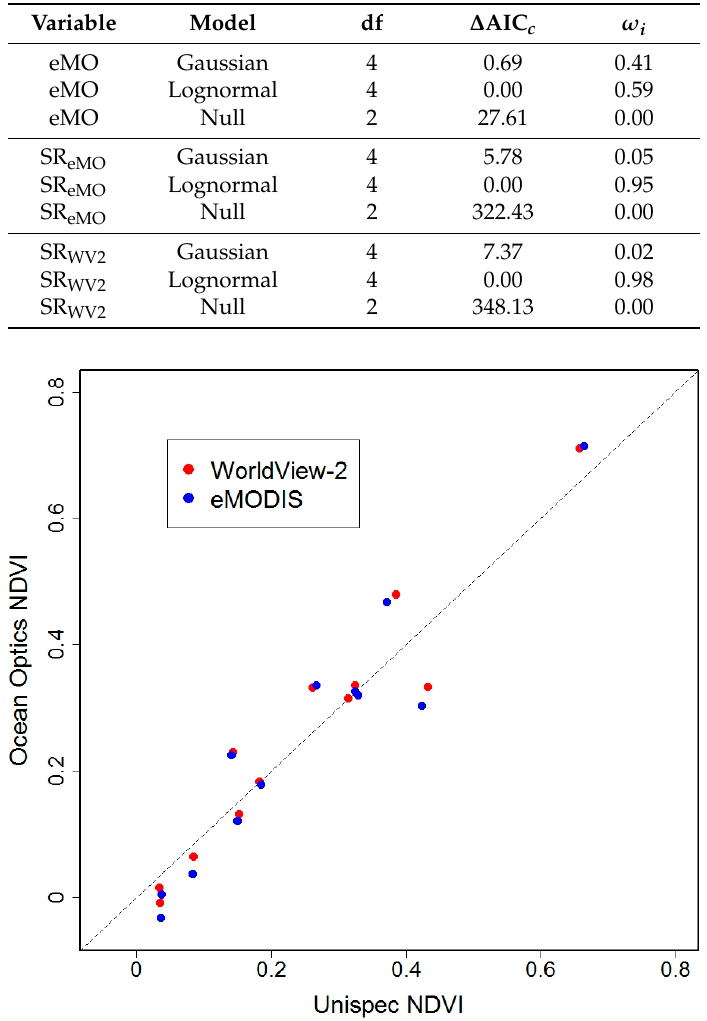
Table A1 . Multi-model selection results for nonlinear curves used to predict seasonal patterns in NDVI and percent nitrogen in halophytic graminoids at the Colville River Delta, Alaska, 2011 ‒ 2015. Results are derived from models fitted with all available data (pooled years) to show overall support for each curve function. eMODIS (eMO) model selection was based on a single pixel value for each date x year combination (n = 46). Spectrometer NDVI curves with eMODIS band definitions (SReMO) and WorldView 2 band definitions (SRWV2) were fit using measurements for all plots at all sampling dates in all years (n = 640). Lowest AIC c scores: − 108.71 (eMO), − 1027.26 (SR eMO ), and − 972.37 (SR WV2 ).